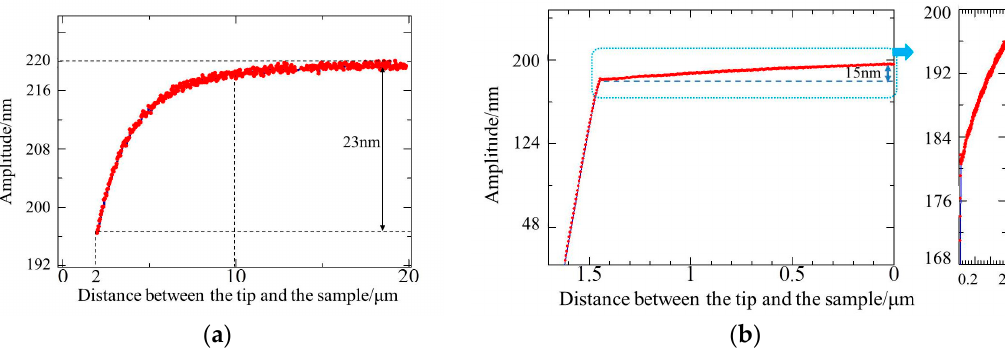
Figure 6. Approach curve of the 3 N/m cantilever in tapping mode ( a ) in the range of 2–20 µm ( b ) within 2 µm.